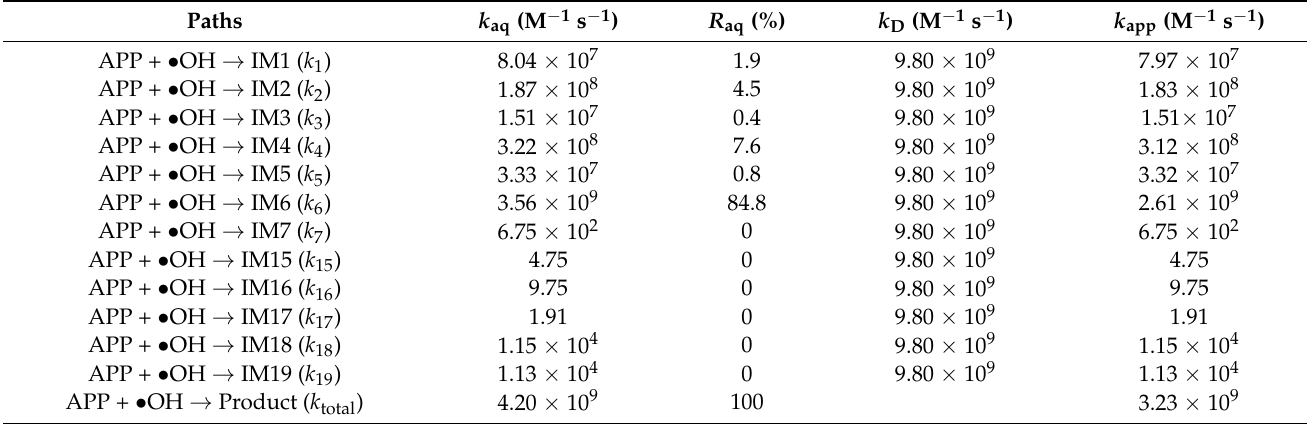
Table 2. The calculated rate constants( k aq ), steady-state rate constant ( k D ), apparent rate constant ( k app ) and branching ratio ( R aq ) for the AAP with • OH reaction in the aqueous phase at 298 K. Paths